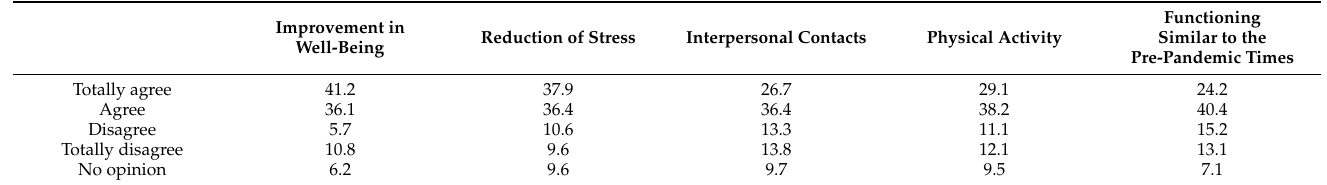
Table 3. Rating the impact of recreation areas on health and activity level during the COVID-19 pandemic